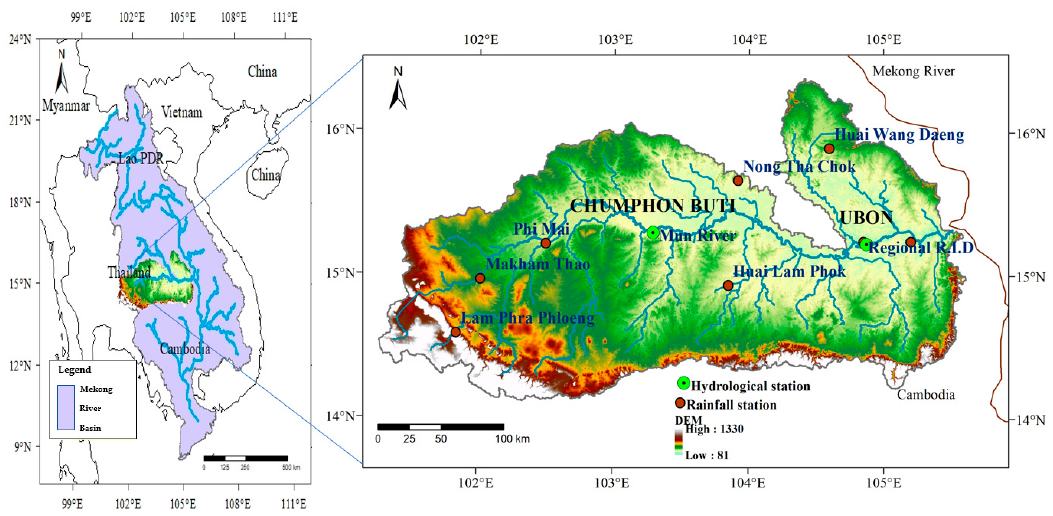
Figure 1. Location of the Mun River basin and the river network.